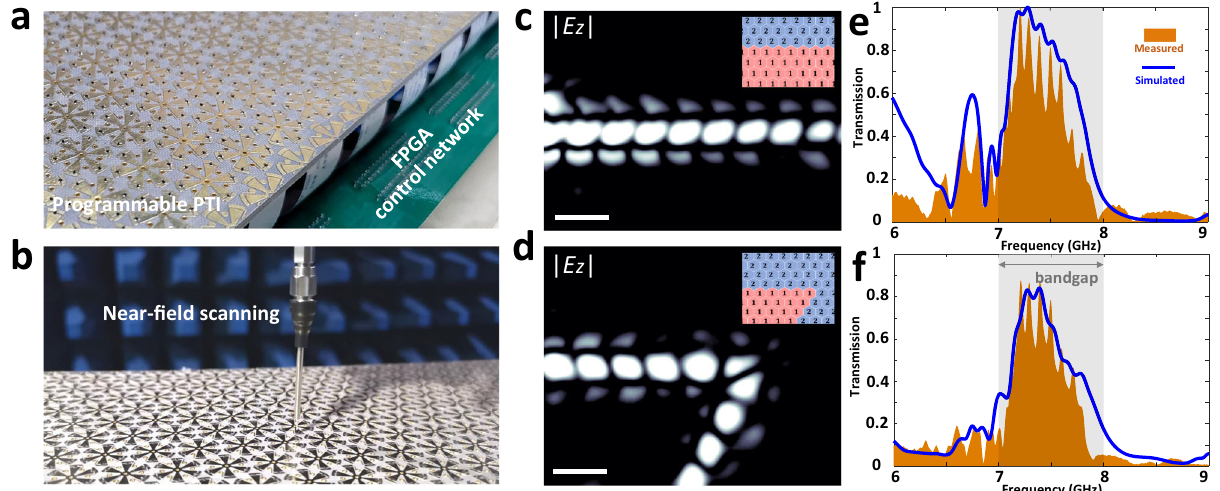
Fig. 3 Experimental results of reprogrammable topological propagation routes. a Photograph of the fabricated RPTI. b Experimental setup of near- fi eld scanning. c , d Measured near- fi eld distributions of | E z | in topological straight and 120-degree-bend waveguides at 7.2 GHz, respectively. The corresponding coding patterns are depicted in insets. White scale bar, 30 mm. e , Comparison of measured and simulated transmissions of a topological straight waveguide. f Comparison of measured and simulated transmissions of a topological 120-degree-bend